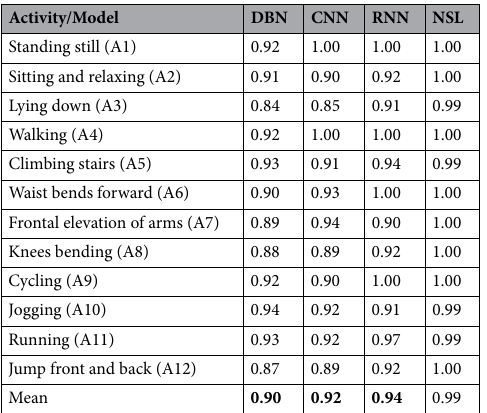
Table 3. The mean recall rates of different activities using different approaches.